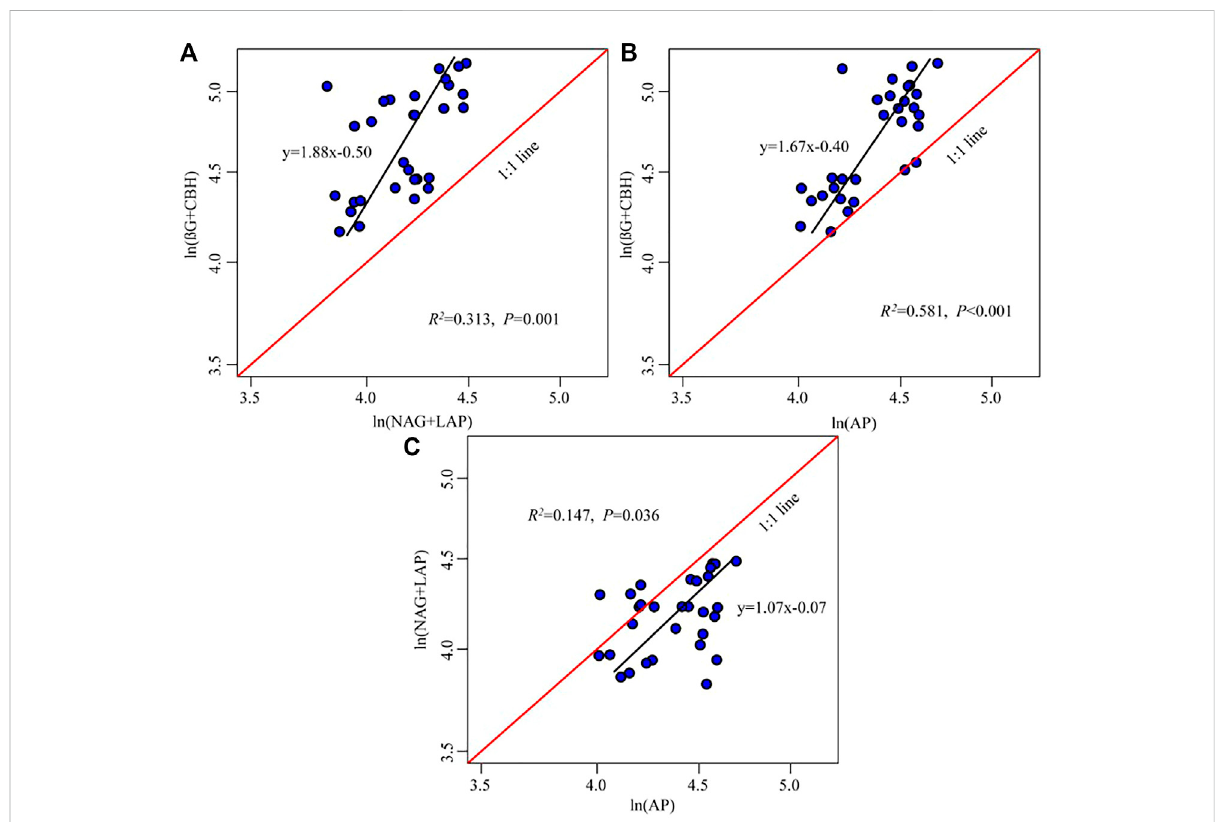
FIGURE 4 Regressions analyses of ln (BG + CBH): ln (NAG + LAP) (A) , ln (BG + CBH): ln (AKP) (B) , and ln (NAG + LAP): ln (AKP) (C) . The black line is the regression line, while the red line is the reference line with slope = 1. The black regression line to the left from the 1:1 line suggests more resources devotedtotheenzymeonthe y -axiscomparedwiththe x -axis[e.g.,ln(BG+CBH)comparedtoln(NAG+LAP)].Theregressionlinetotherightfrom the 1:1 line suggests more resources devoted to the enzyme on the x -axis compared with the y